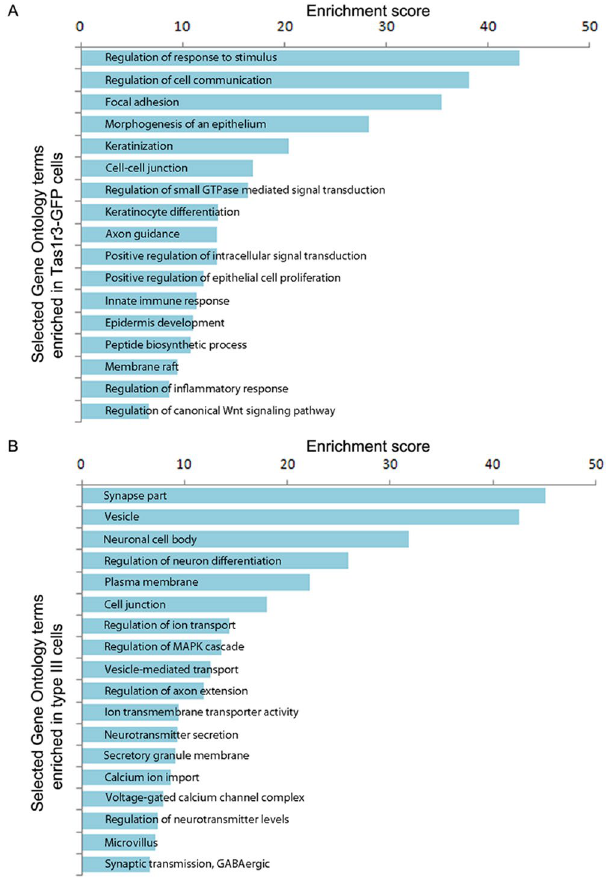
Figure 2. Selected Gene Ontology categories enriched in Tas1r3 + cells ( a ) or type III cells ( b ) relative to all annotated genes in the genome. Bar plots show some GO terms associated with previously identified biological properties of Tas1r3 + and type III cells identified by GO enrichment